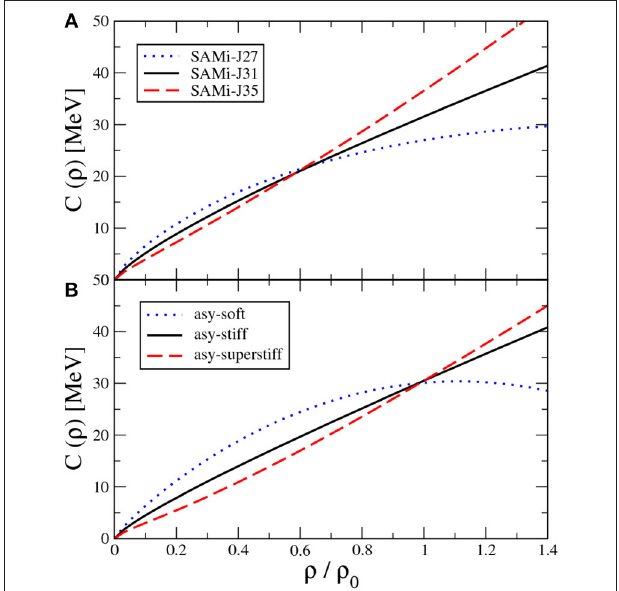
FIGURE 1 | (Color online) Density dependence of the symmetry energy for the EoS with (upper panel) or without (lower panel) momentum dependence ( ρ 0 = 0.16 fm − 3 ). Readapted from Zheng et al. [